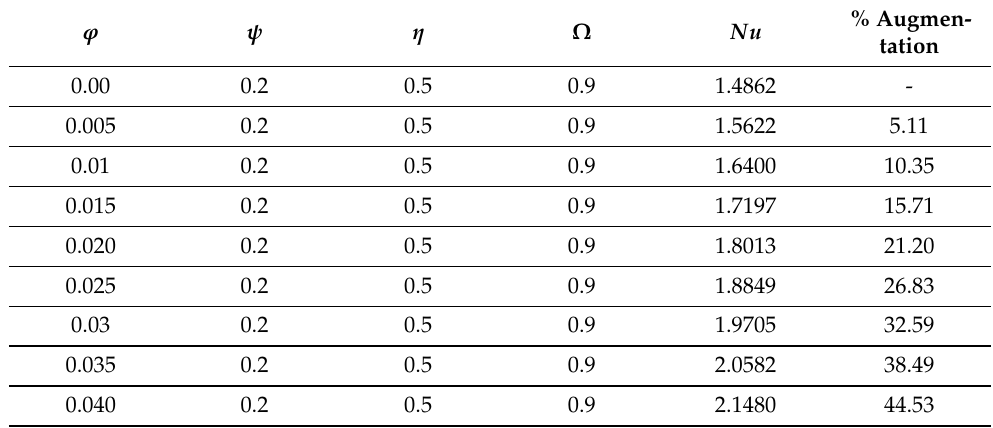
Table 4. Investigation of Nu and augmentation percentage for variation of ϕ .